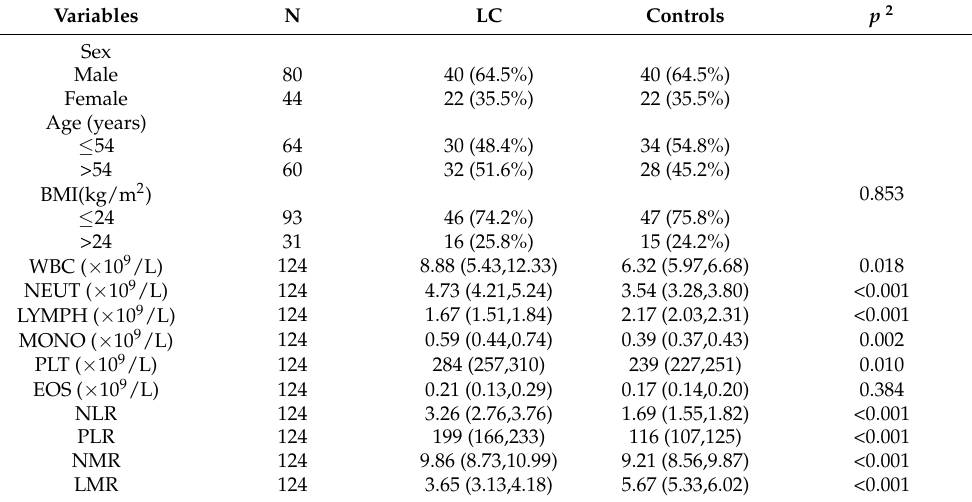
Table 1. Characteristics and blood parameters of participants between LC and control group 1 .